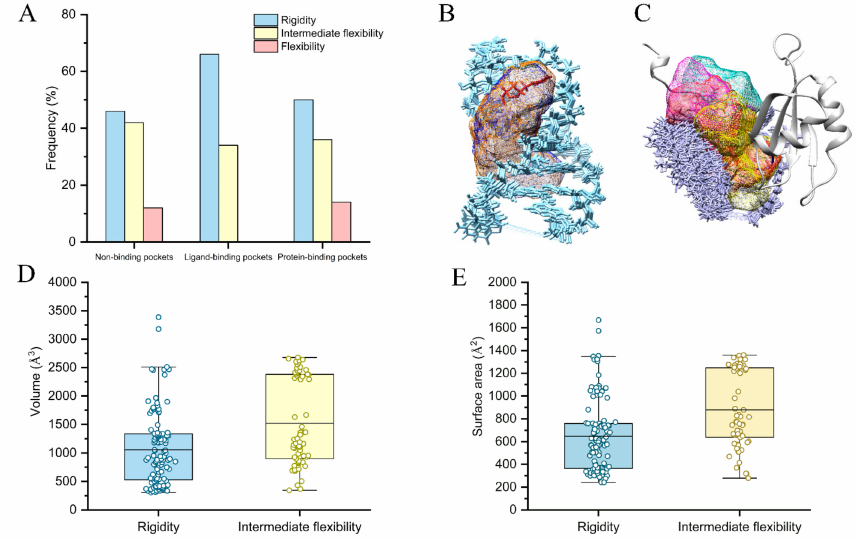
Figure 4. ( A ) The frequency of non-, ligand-, and protein-binding pockets in three classes of flexibility. ( B , C ) The examples of structure views of rigidity ligand-binding (2KX8-G2) and flexibility protein- binding pockets (2N82-G1). The topological information distribution of volume ( D ) and surface area ( E ) for ligand-binding pockets. The mean values are colored